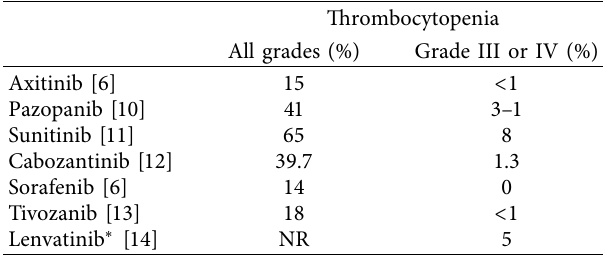
Table 2: Thrombocytopenia induced by VEGFR TKIs in